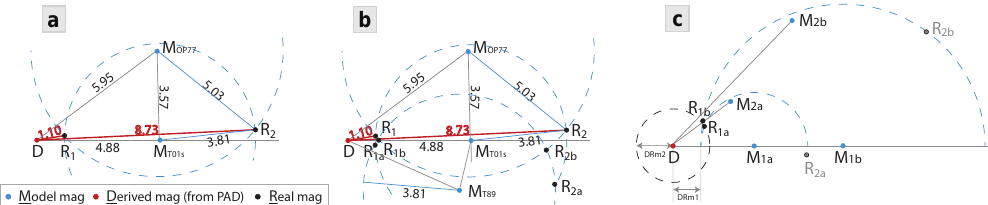
Figure 8. Determining the position of R point(s) using multiple empirical models. (a) A circle is drawn around each of the points M T01s and M OP77 from the two models, and the intersections give two candidate points R 1 and R 2 . (b) The introduction of another point M T89 (from the T89 model) and its circle generate R 1a and R 1b points very close to the R 1 , as well as R 2a and R 2b points spreading away from R 2 . (c) R 1 and R 2 points are determined for different magnetic activity categories. Since the DR m1 and DR m2 basically stay constant with magnetic activity, the grouping of R 1 points should be much tighter than that of R 2